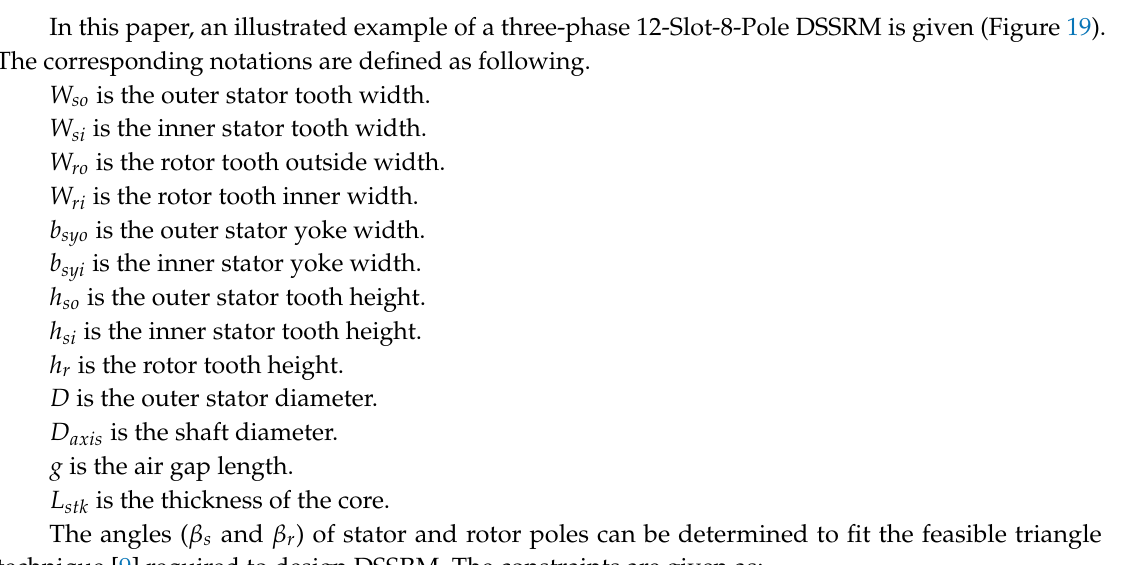
Figure 18. Plot of the variation of the co-energy corresponding to MMF.